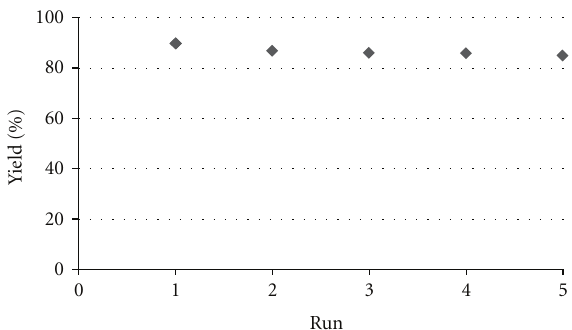
S 2: Postulated roles of Al-MCM-41 in the ring opening reaction of epoxides.